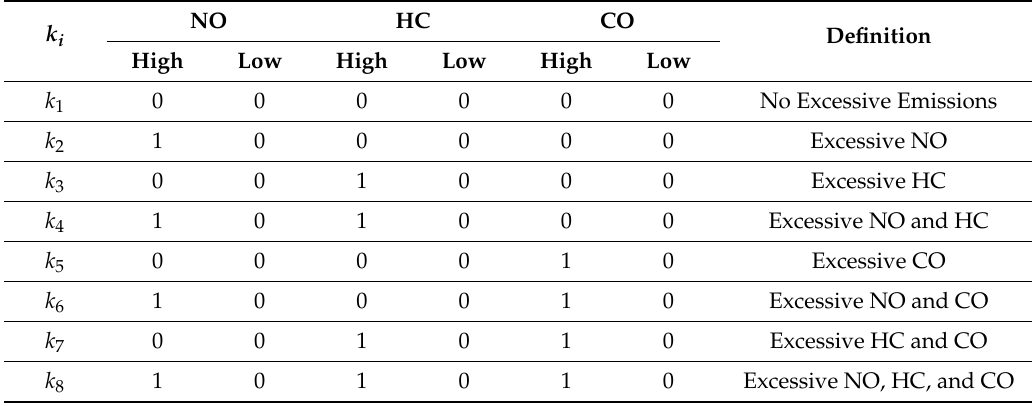
Table 1. The labels and definitions of di ff erent k